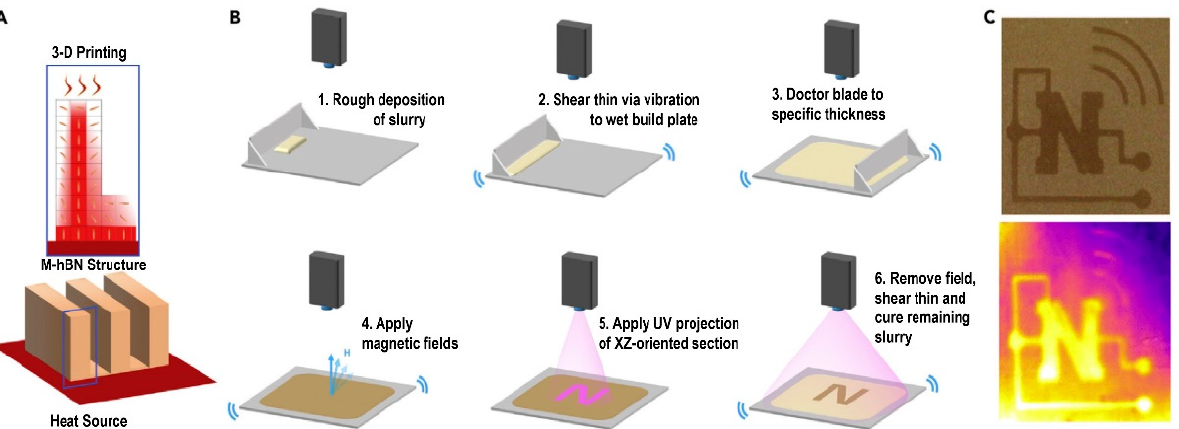
Figure 3. ( A ) SLA, magnetic field induction, and vibration are combined in a novel 3D printing process to create composites with specific thermal conduction pathways; ( B ) schematic of the fabrication of specific thermal pathways through a customized 3D printing procedure employing mhBN-acrylate as the raw material; ( C ) visible light (top) and thermal capture (bottom) of the composite, with mhBN oriented out-of-plane in the “N”-shaped and semiarc ring sections, which correspond to higher temperatures under the infrared camera (yellow) (reproduced with permission from Reference [34], Copyright 2020 Elsevier).